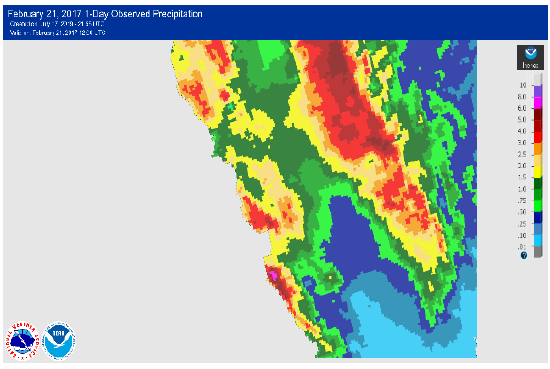
Figure 3. Cumulative rainfall (inches) across SFBA for 12Z–12Z, 20–21 February 2017.